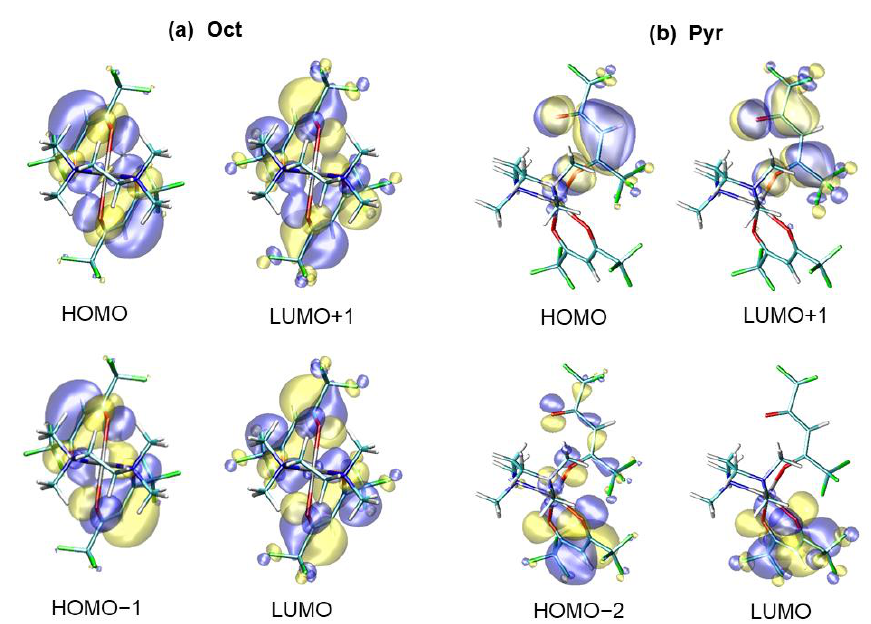
Figure 4. ( a ) Molecular orbitals (MOs) involved in the π – π * ligand-to-ligand electronic transitions for Zn(hfa) 2 TMEDA-Oct in ethanol. The main components of the transition were at λ = 273 nm (oscillator strength = 0.376) (HOMO → LUMO + 1 and HOMO − 1 → LUMO excitations) and λ = 281 nm (oscillator strength = 0.109) (HOMO → LUMO and HOMO − 1 → LUMO + 1 excitations). ( b ) MOs involved in the π–π* ligand-to-ligand electronic transitions for Zn(hfa) 2 TMEDA-Pyr in ethanol. Main components at λ = 269 nm (oscillator strength = 0.383) (HOMO → LUMO+1 excitation) and λ = 276 nm (oscillator strength = 0.252) (HOMO − 2 → LUMO excitation). Blue and yellow colors mark positive and negative phases of the MOs, respectively.